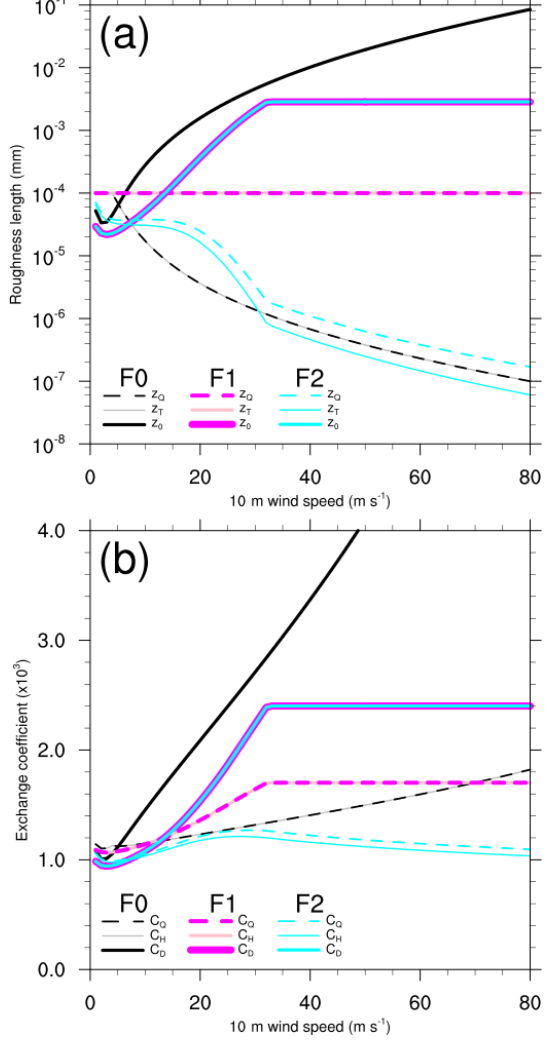
Figure 1. Plots of (a) roughness lengths and (b) bulk transfer co- efficients versus wind speed at 10m height for neutral conditions. Flux schemes F0, F1, and F2 are colored black and gray, red and pink, and green. The thick solid curves are z 0 and C D , thin solid curves are z h and C H , and dashed curves are z q and C Q . It is noted that some curves are identical. For F1 and F2, z 0 (and thus C D ) is the same; for F1 and F2 the respective heat and moisture roughness and coefficients are the same: z h = z q and C H = C Q